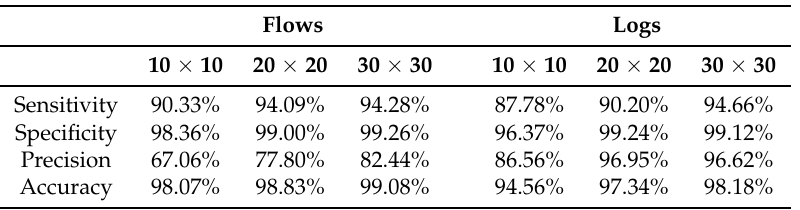
Table 1. Experiment